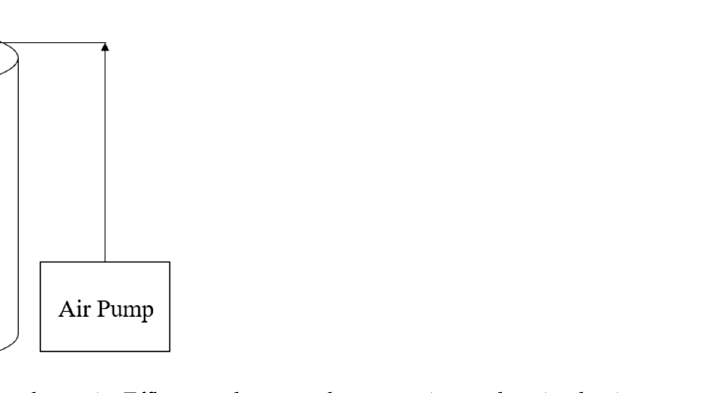
Figure 1. Aerobic reactor schematic. Effluent to be treated was continuously mixed using constant aeration. Samples were taken by removing the reactor lid to access the effluent.